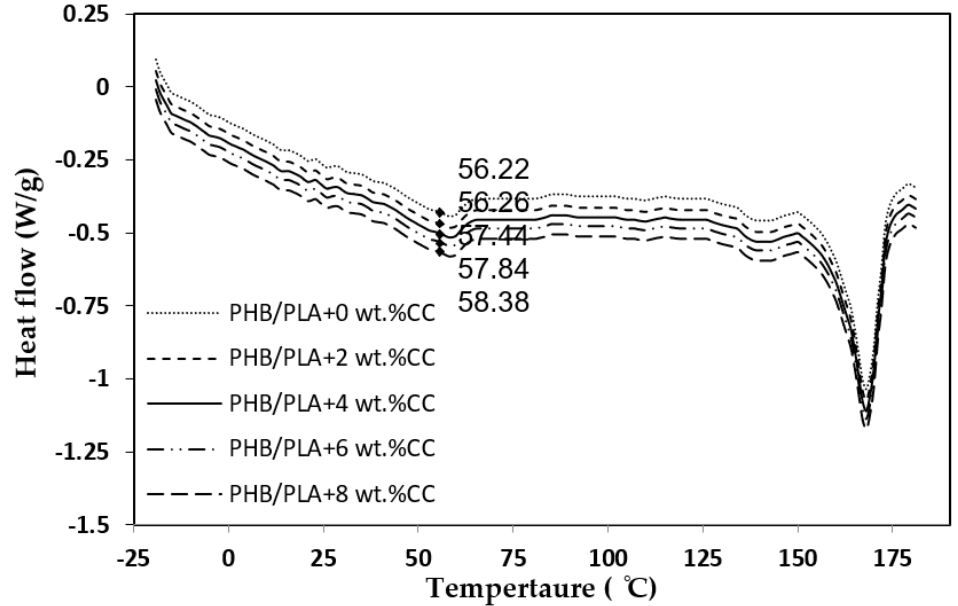
Figure 13. A DSC thermograph showing the effect of corncob fillers on the T g and melt peaks of the composites. Table 4. T g -onset, midpoint, and end temperatures of the composites.